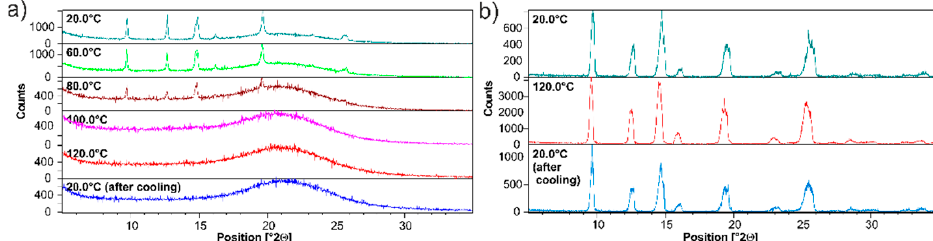
Figure 6. PXRD of ( a ) physical mixture ET/SiO 2(hydr) , ( b ) pure ET in the range of temperatures (20–120 °C). Recorded on a PANalytical 3 kW system in Bragg–Brentano geometry and with a Cu K α ( λ = 1.5425 Å) source equipped with CHC plus Anton Paar chamber.